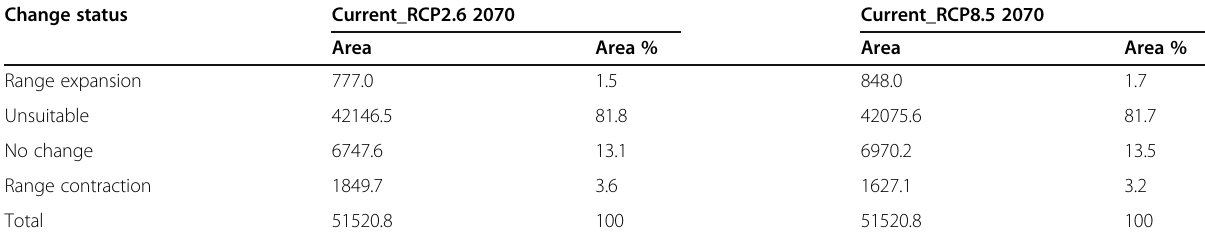
Table 5 Difference between the current and future distribution of Q. aegilops under two different climate change scenarios for 2070 (RCP 2.6 2070 and RCP 8.5